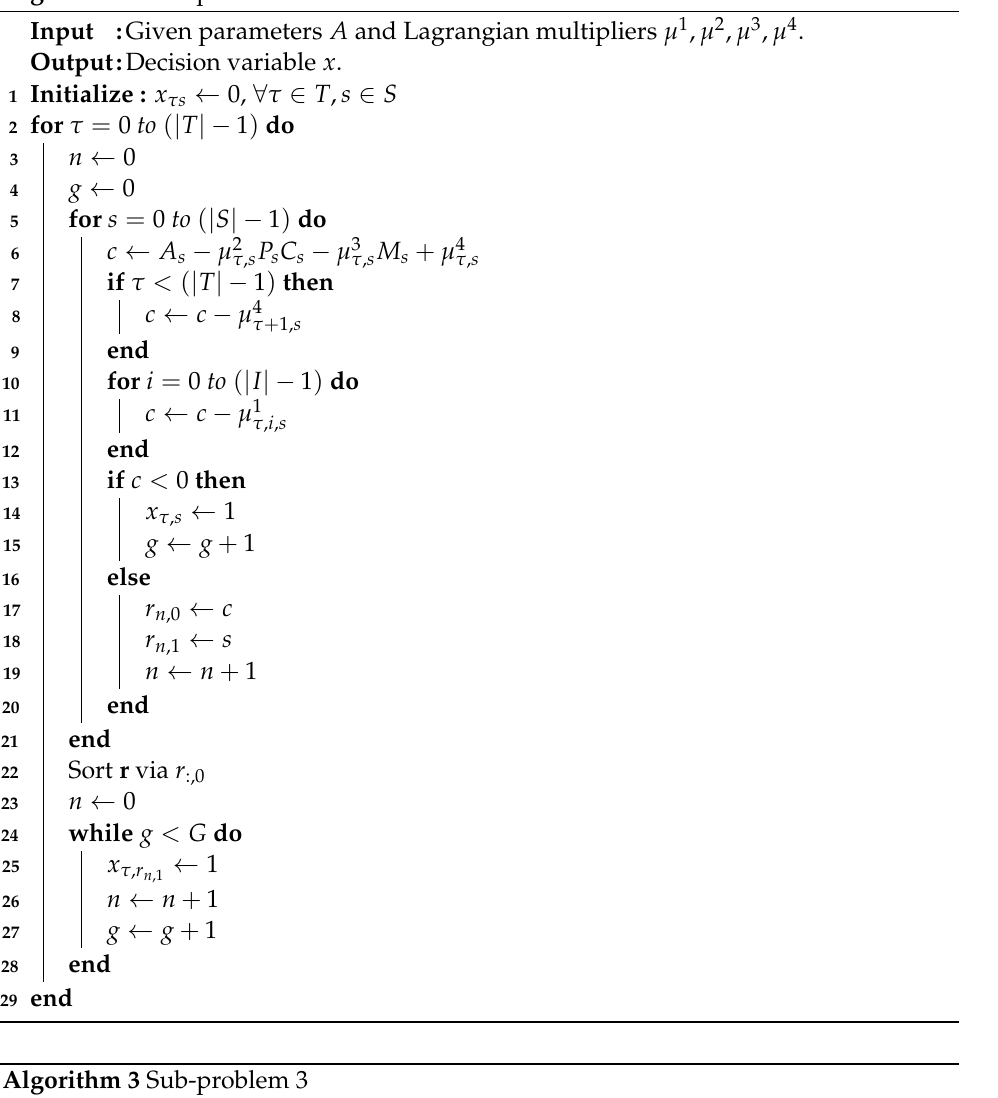
Algorithm 2 Sub-problem 2